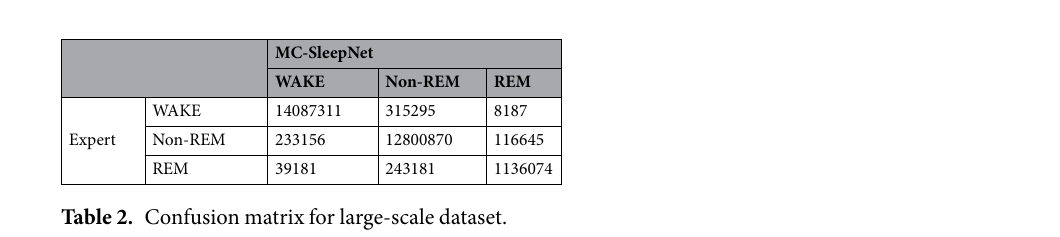
Figure 3. Example of sleep stage scoring result by MC-SleepNet.